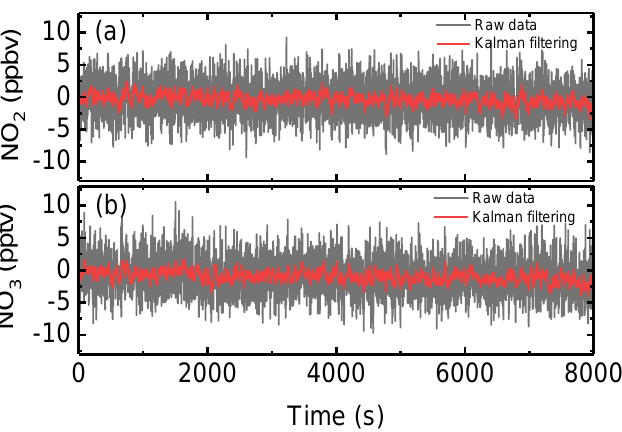
Figure 11. The raw data (grey line) measured by OP ‐ IBBCEAS with the chamber filled with zero air, and the measured data after applying Kalman filtering (red line). ( a ) The measured NO 2 data with and without Kalman filtering. ( b ) The measured NO 3 data with and without Kalman filtering.